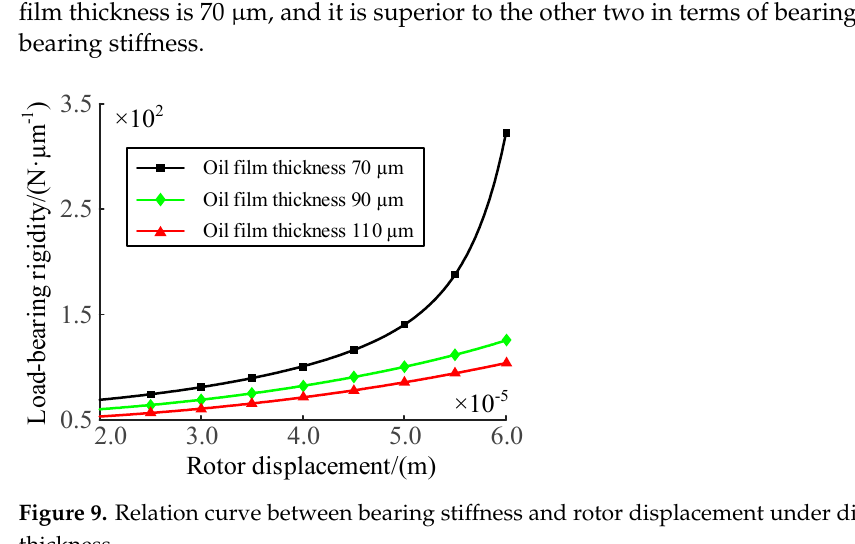
Figure 9. Relation curve between bearing stiffness and rotor displacement under different oil film thickness.